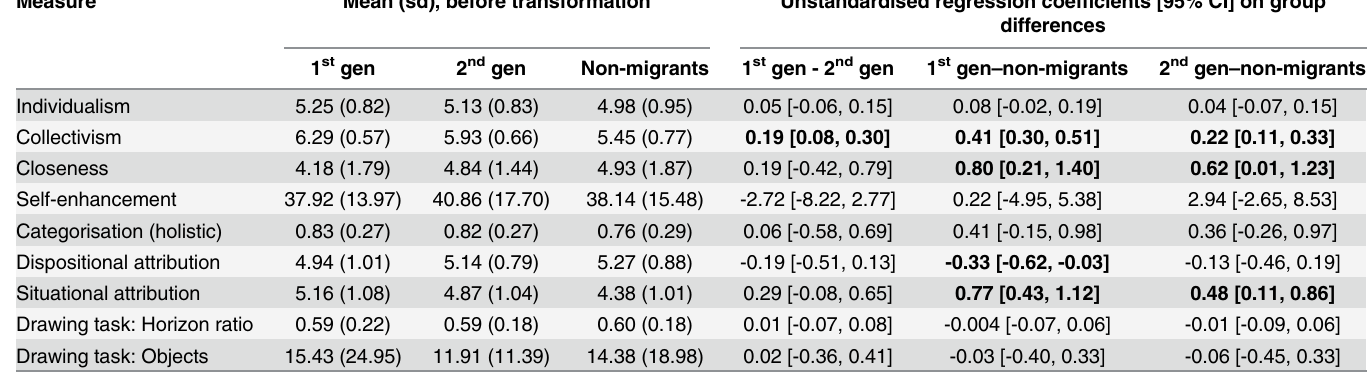
Table 4. Summary of culture-only means and regression coefficients. Means and standard deviations are raw values before transformation. Unstandar- dised regression coefficients estimate the difference denoted in the column heading, with 95% confidence intervals in square brackets. Note that in the regressions several measures are logged, and some models are non-linear (see text for details), so coefficients should not be compared across models/mea- sures. Differences comprising CIs that do not cross zero are shown in bold. 1 st gen = 1 st generation British Bangladeshi, 2 nd gen = 2 nd generation British Ban- gladeshiFor categorisation, higher values indicate holistic cognition, lower indicate analytic.